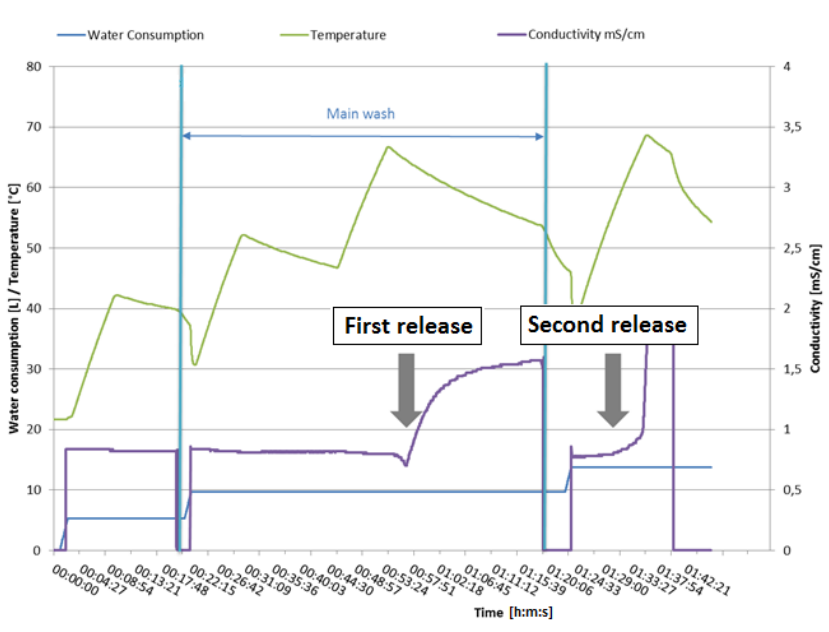
Figure 16 – Observed electric conductivity of water [ mS / cm ] , water temperature [ ◦ C ] , and amount of water [ l ] during a washing